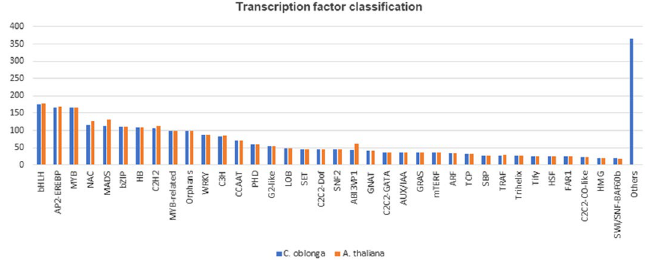
Figure 2. Distribution of C. oblonga transcription factors (TFs) based on plant TF families. C. oblonga TF distribution is displayed with respect to the distribution of Arabidopsis homologs. x-axis displays TF families and y-axis displays number of TF assignments to families. TF families with less than 20 representations in the set of identified C. oblonga TFs are included in the ‘Others’ class.